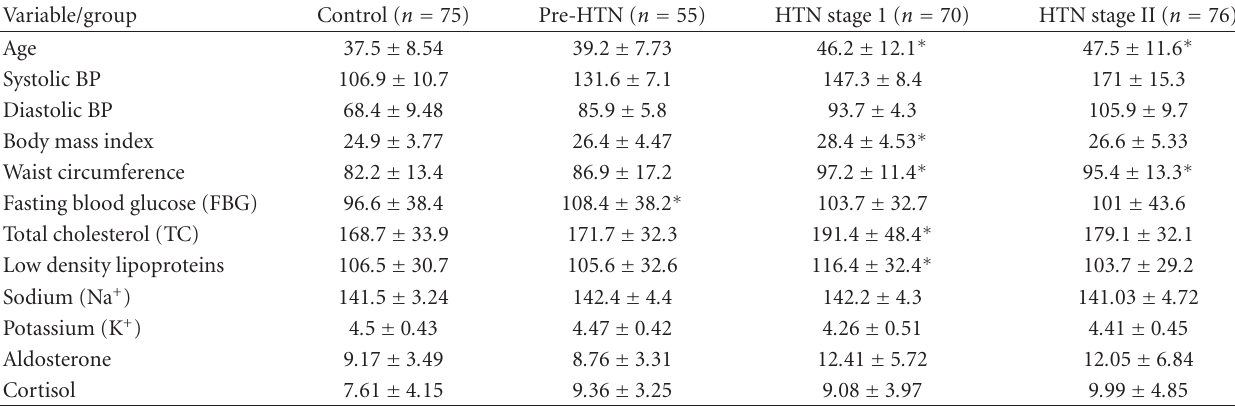
Table 1: Mean values of di ff erent variables (mean ± SD) in controls and stages of